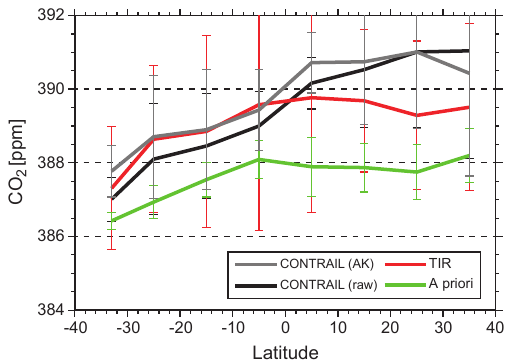
Figure 5. Comparisons among CONTRAIL (raw), CONTRAIL (AK), GOSAT/TANSO-FTS TIR, and a priori (NIES TM 05) CO 2 data during flights between Tokyo and Sydney (NRT_SYD) in northern hemispheric spring (MAM), shown by black, gray, red, and green lines, respectively. The means and their 1 σ standard de- viations were calculated in each area during the flight for all four data